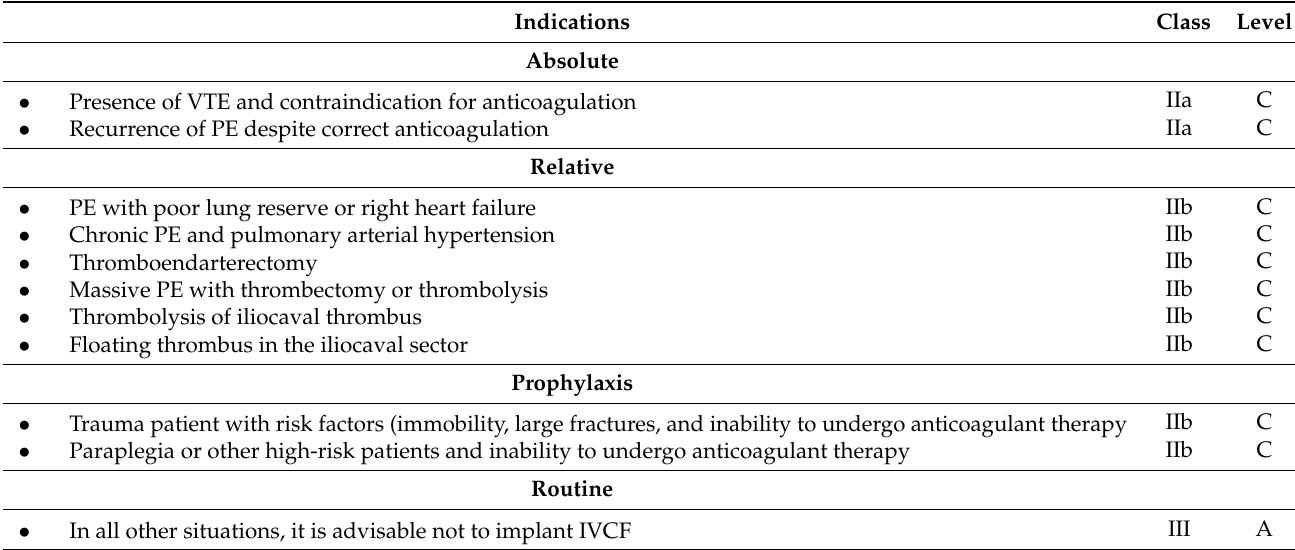
Table 1. Indications of IVCF (modified from the SIR) [13,14,21].